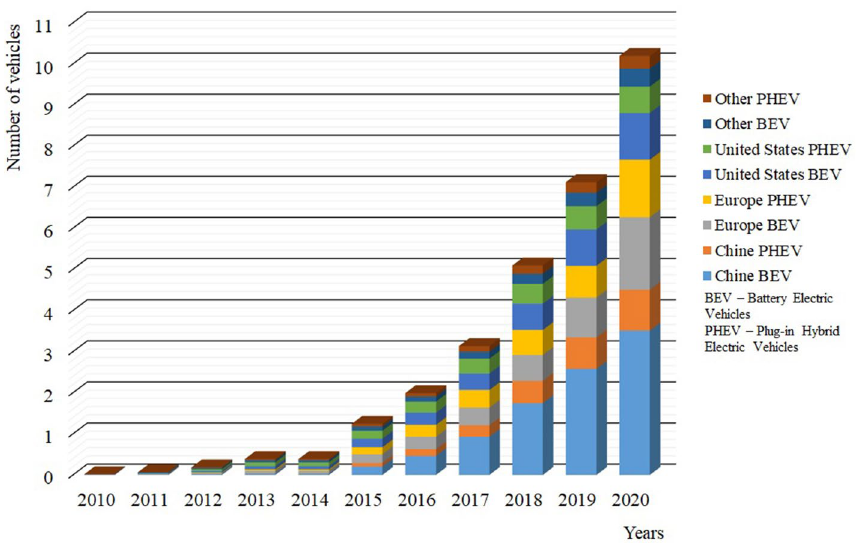
Figure 1. Global electric passenger car stock, 2010–2020 9